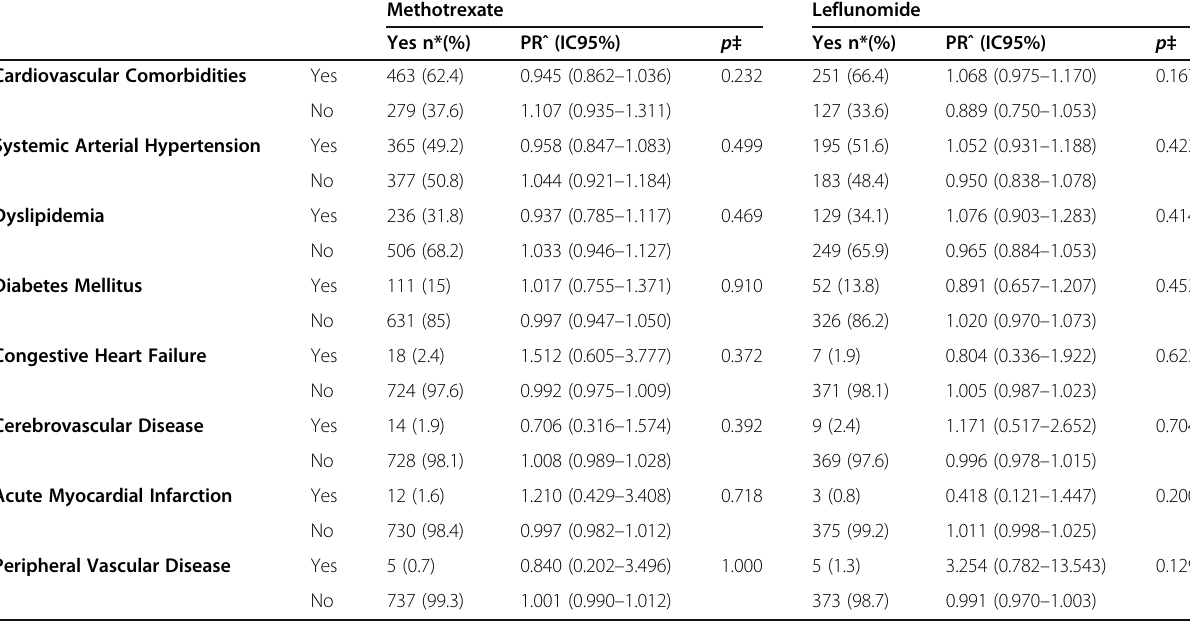
Table 5 Association between cardiovascular comorbidities and the use of Methotrexate and Leflunomide